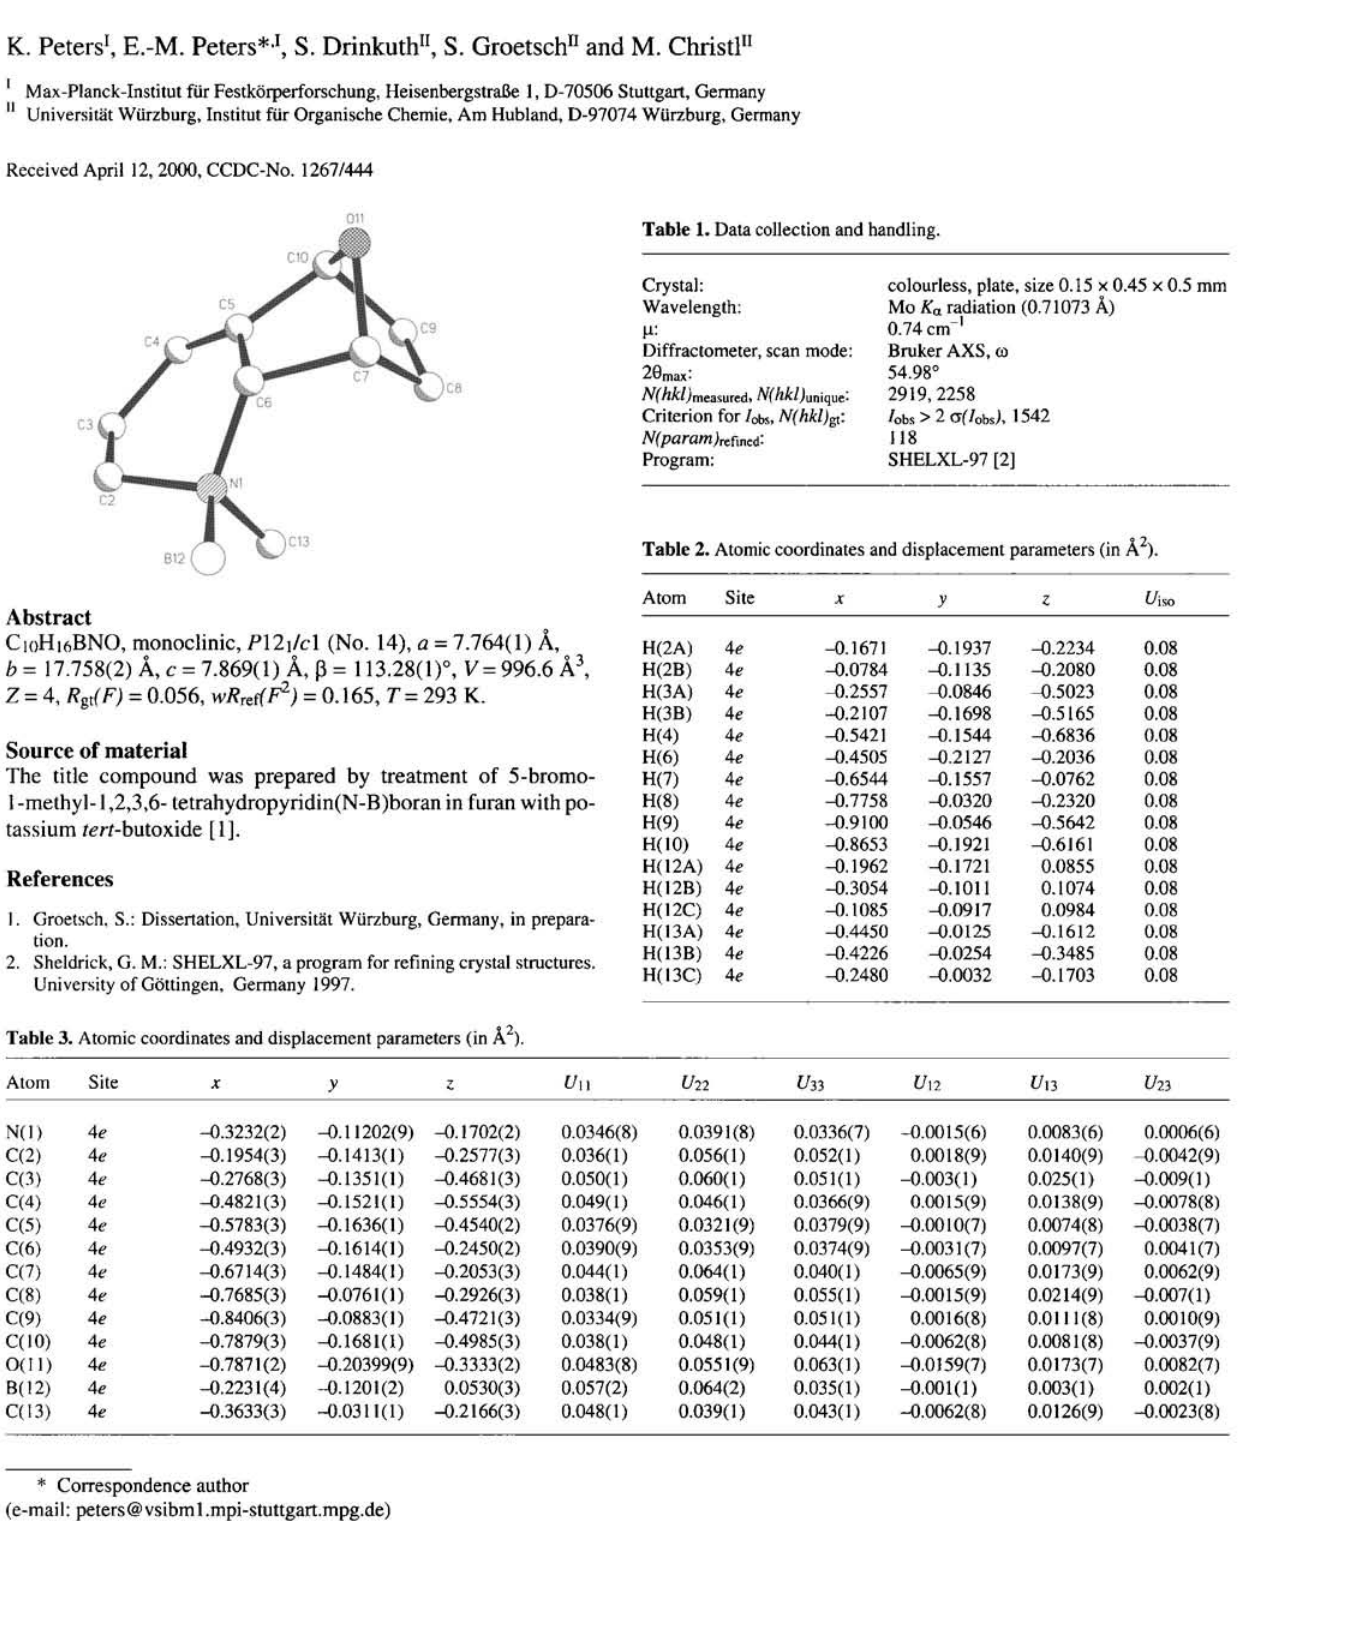
Table 1. Data collection and handling.